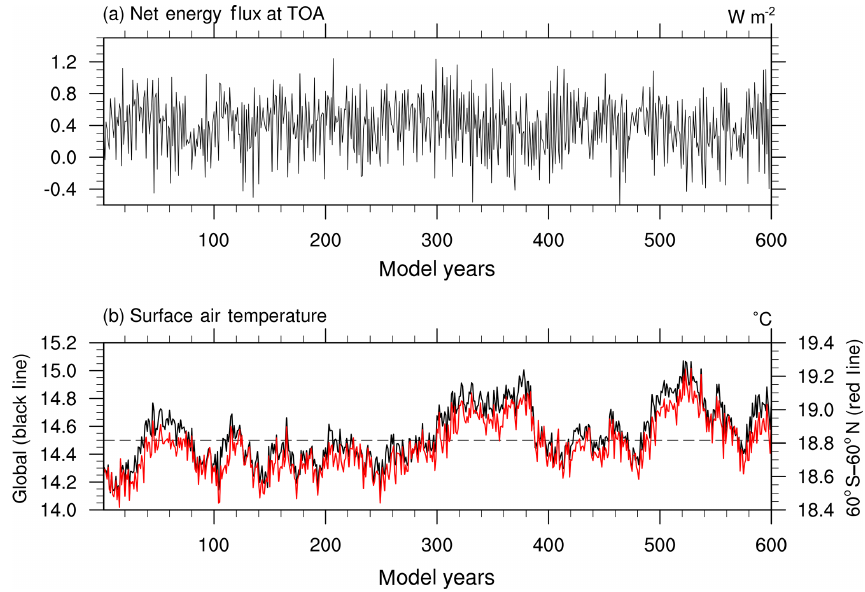
Figure 2. Time series of (a) the global mean net energy flux at top-of-atmosphere (Wm − 2 ) and (b) the global (black line) and regional (60 ◦ S to 60 ◦ N, red line) surface air temperature ( ◦ C) for the 600 years of piControl